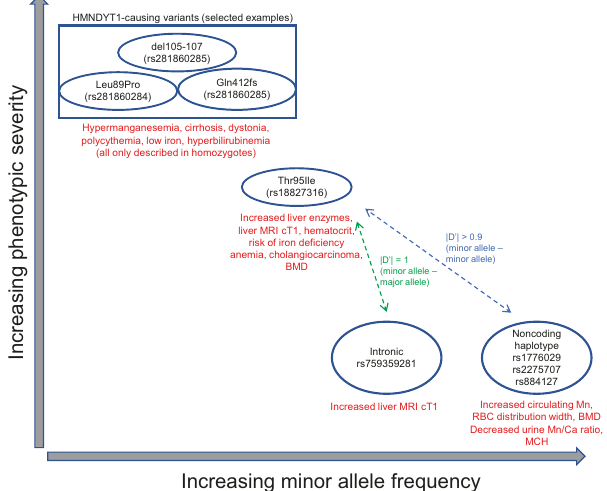
Fig. 7 Relationship of Mendelian and common-variant GWAS phenotypes at the SLC30A10 locus. Phenotypes are summarized for HMNDYT1- causing variants, SLC30A10 Thr95Ile, and GWAS